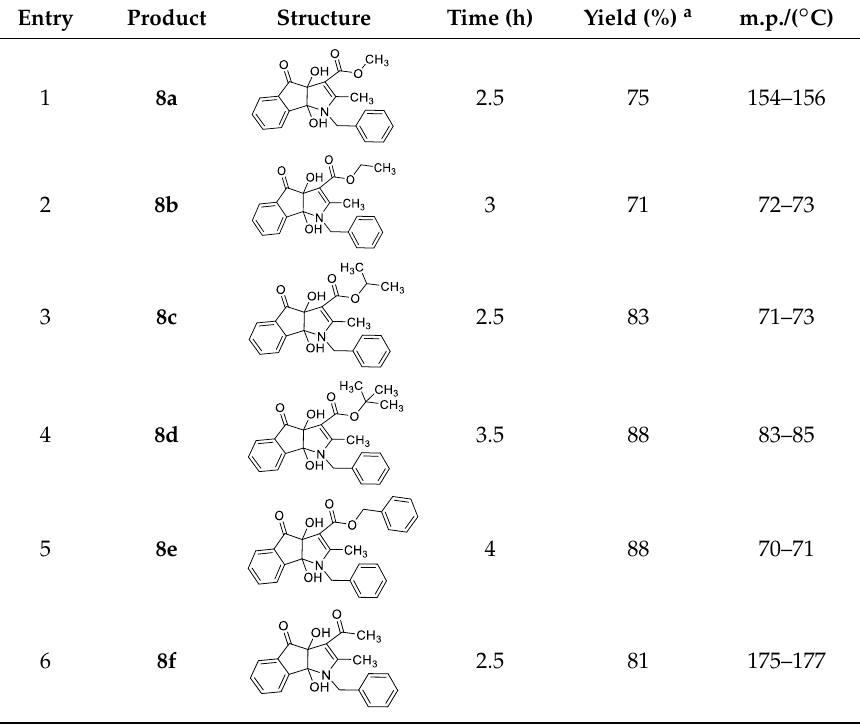
Table 4. The synthesis of compounds 8 Table 4. The synthesis of compounds 8 . Table 4. The synthesis of compounds 8 . Table 4. The synthesis of compounds 8 . Table 4. The synthesis of compounds 8 . Table 4. The synthesis of compounds 8 . Table 4. The synthesis of compounds 8 .